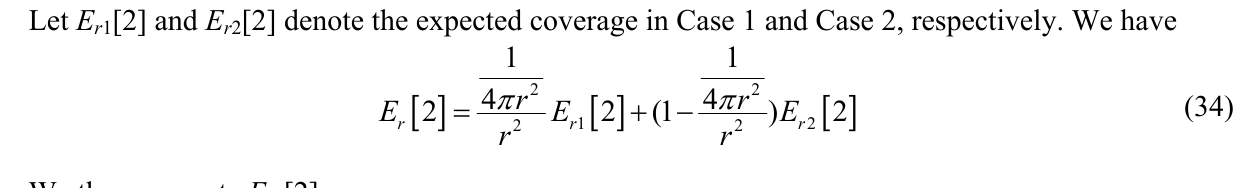
Figure 14. Two cases of a sensor’s location in sub-region Ω (a)case1